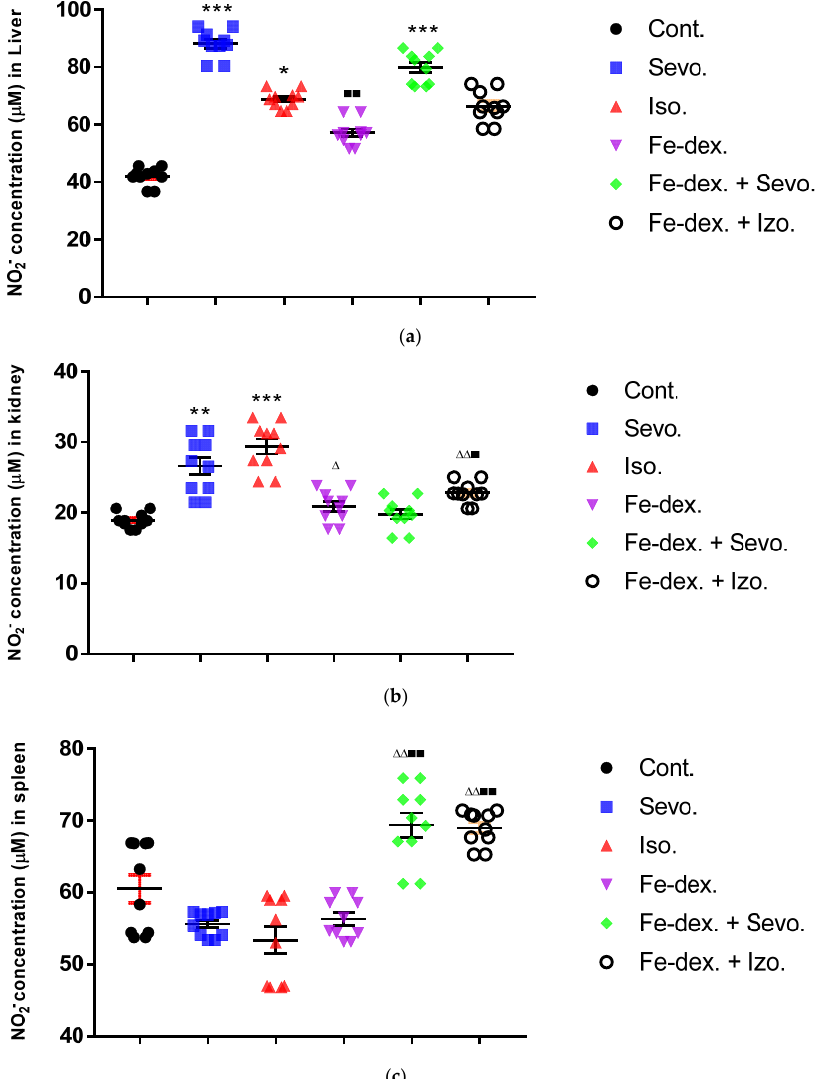
Figure 5. Effect of inhaled anesthetics and iron dextran on the nitric oxide (NO) activity in liver ( a ), kidney ( b ), and spleen ( c ) of rats treated for 28 days. Rats ( n = 10 per group) were treated with ip injection of iron dextran (50 mg/kg), exposed to 2.4 vol % sevoflurane inhalation and 1.3 vol % isoflurane inhalation, and exposed to a combination thereof where inhaled anesthetics were given 2 h after ip injection of iron dextran. Animals were treated every other day for 28 days. Each animal sample is indicated by a single dot. The results are expressed as the mean value of each experimental group ± SE. * Statistically significant compared to the control group (* p < 0.05; ** p < 0.01; *** p < 0.001); ■ Statistically significant compared to the sevoflurane group ( ■ p < 0.01; ■■ p < 0.01); ∆ Statistically significant compared to the isoflurane group ( ∆ p < 0.05; ∆∆ p < 0.01). Other statistically significant changes exist in: ( a ) NO 2 − concentration ( µ M) in liver—Fe-dex. vs. Fe-dex. + Sevo. ( p < 0.05); ( c ) NO 2 − concentration ( µ M) in spleen—Fe-dex. vs. Fe-dex. + Sevo. ( p < 0.05); Fe-dex. vs. Fe-dex. + Iso. ( p < 0.05). Abbreviations: Cont., control group; Sevo., sevoflurane group; Iso., isoflurane group; Fe-dex., iron dextran group; Fe-dex. + Sevo., group treated with iron dextran and sevoflurane; and Fe-dex. + Iso., group treated with iron dextran and